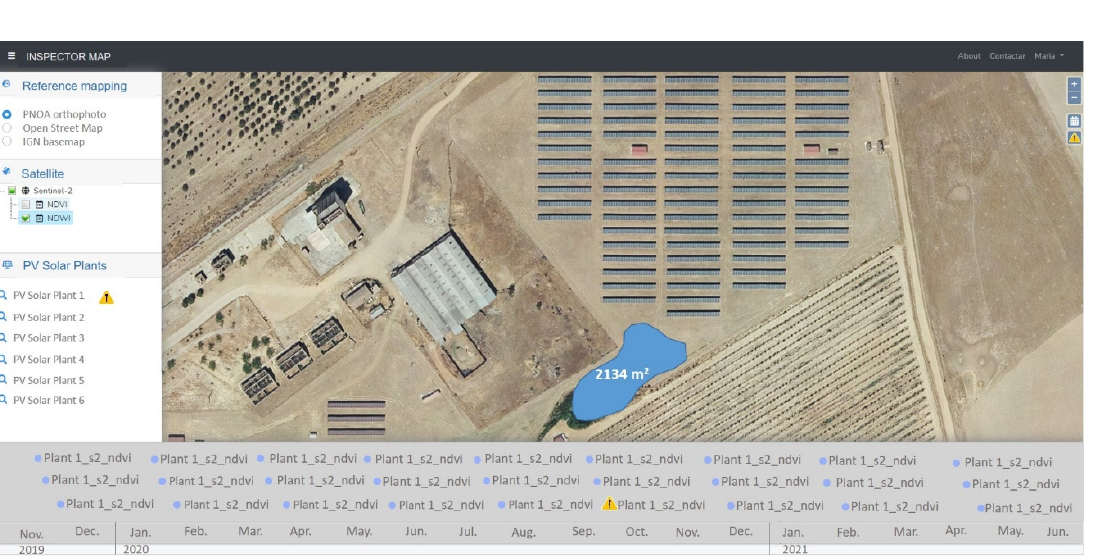
Figure 13. Body of water detected on plant 1 by the INSPECTORMAP alert system during an episode of heavy rain.